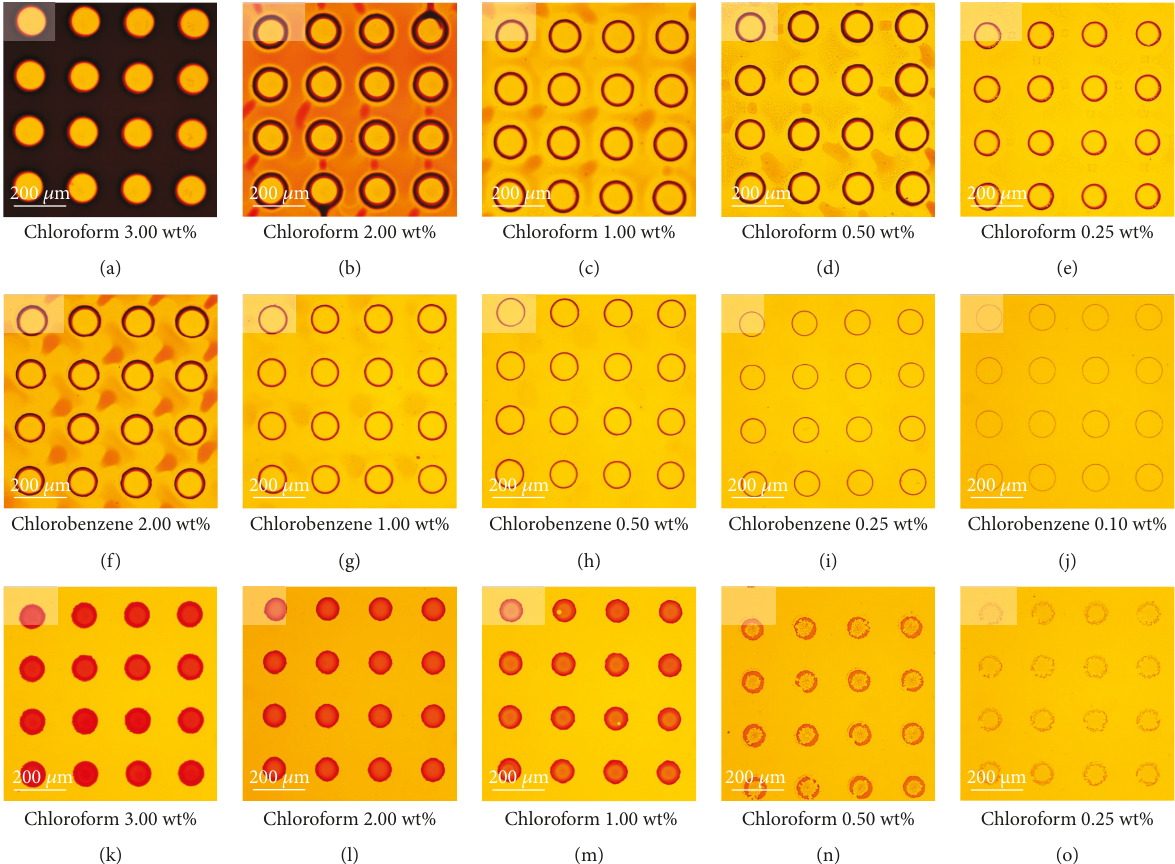
Figure 2: Optical microscopy images of the patterned P3HT layers using the PDMS mold with the pillar array of 100 μ m diameter. (a – e) The negatively patterned P3HT layers using chloroform as a solvent. The PDMS molds were used as templates for dewetting of the polymer solutions, accompanying with solvent evaporation. The solution concentrations were (a) 3.00, (b) 2.00, (c) 1.00, (d) 0.50, and (e) 0.25wt%, respectively. (f – j) The negatively patterned P3HT layers, prepared with chlorobenzene as a solvent following the same procedure as for chloroform. The solution concentrations were (f) 2.00, (g) 1.00, (h) 0.50, (i) 0.25, and (j) 0.10wt%, respectively. (k – o) The positively patterned P3HT layers via direct contact printing. The chloroform solvent was solely used for spin-coating deposition of the polymer on the PDMS surface due to serious dewetting issues. The solution concentrations were (k) 3.00, (l) 2.00, (m) 1.00, (n) 0.50, and (o) 0.25wt%,